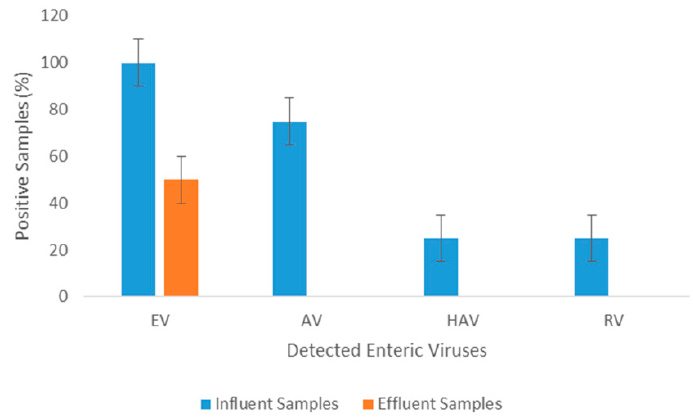
Figure 5. Detection frequencies (%) of enteric viruses (EV, AV, HAV, and rotaviruses (RV)) in the influent and effluent sewage samples during sampling periods.